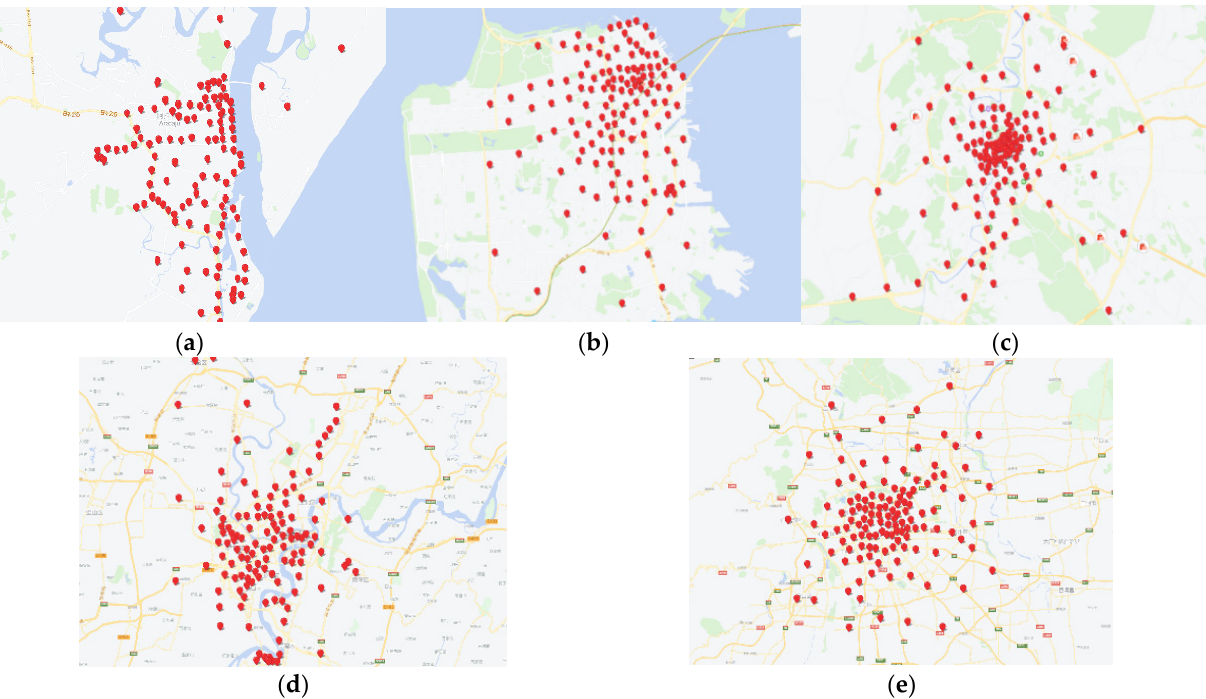
Figure 10. The city hotspot markers for the city taxi GPS data found by the K-means method: ( a ) Aracaju (Brazil), ( b ) San Francisco (USA), ( c ) Rome (Italy), ( d ) Chongqing (China), ( e ) Beijing